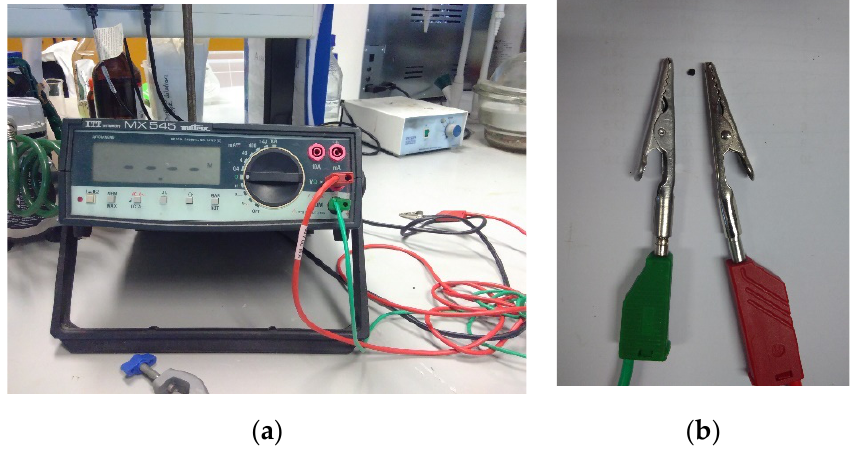
Figure 5. Electrical resistivity apparatus set up: ( a ) ITT Matrix MX 545 digital mustimeter and ( b ) positioning of current transferring pins and capsule.